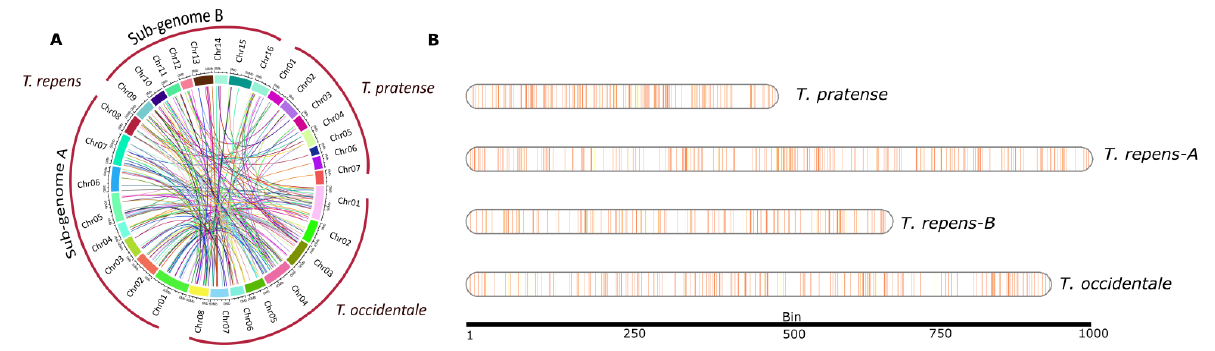
5 of 12 Figure 1. Horizontal bar graph exemplifies the organization of NLR genes that include four signifi- cant sub-class denoted in four different colors. 3.2. Landscape of NLR Genes among Trifolium Species